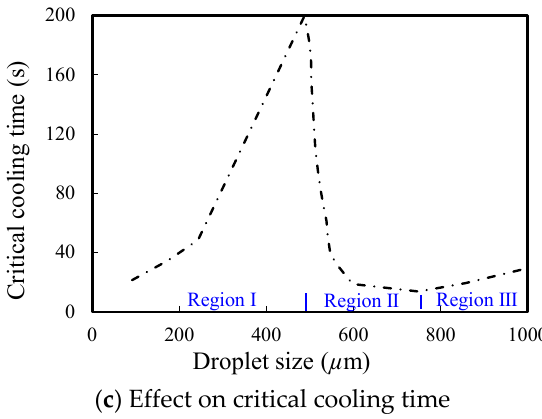
Figure 12. Effect of various water mist droplet sizes [19].